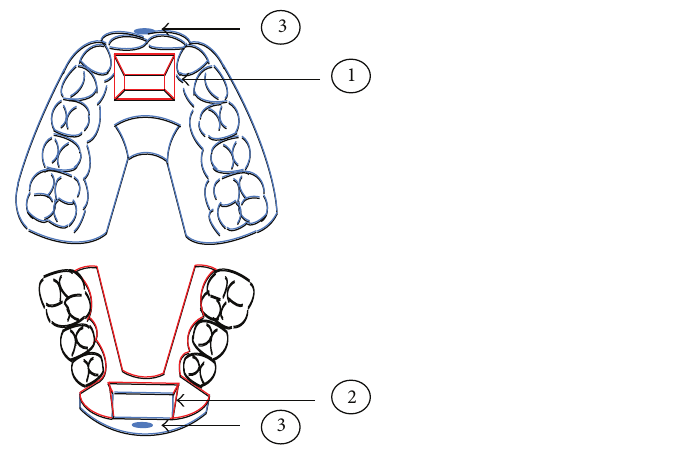
Figure 1: Schematic diagram of HAF appliance design. (1) Advancement bar. (2) Guiding surface. (3) Buttons (in blue ink: thermoplastic parts, in red ink: acrylic parts).